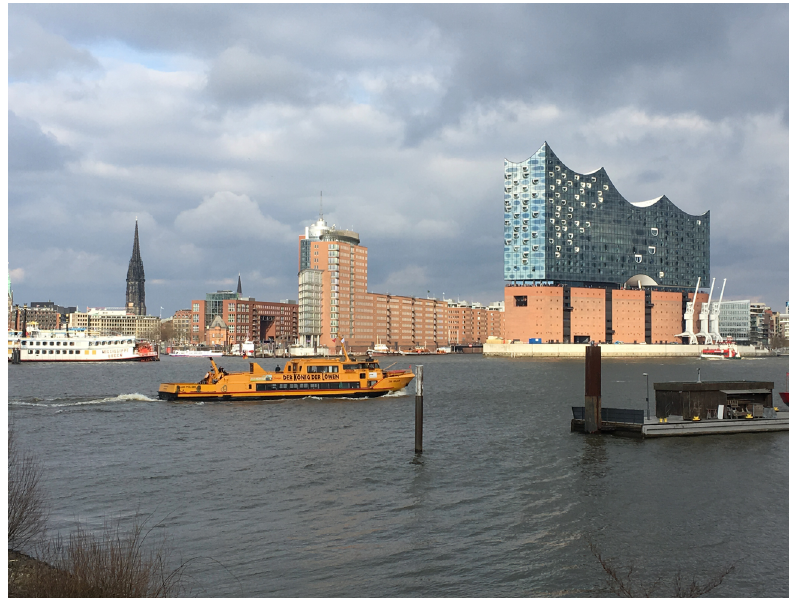
FIG. 1 The Elbhilharmonie (Image by Carola